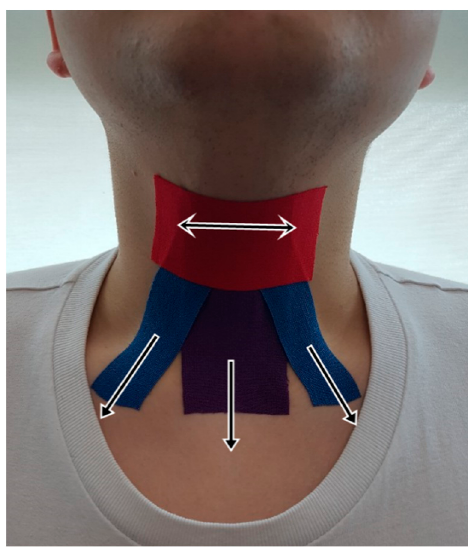
Figure 1. Application of the kinesiology tape.